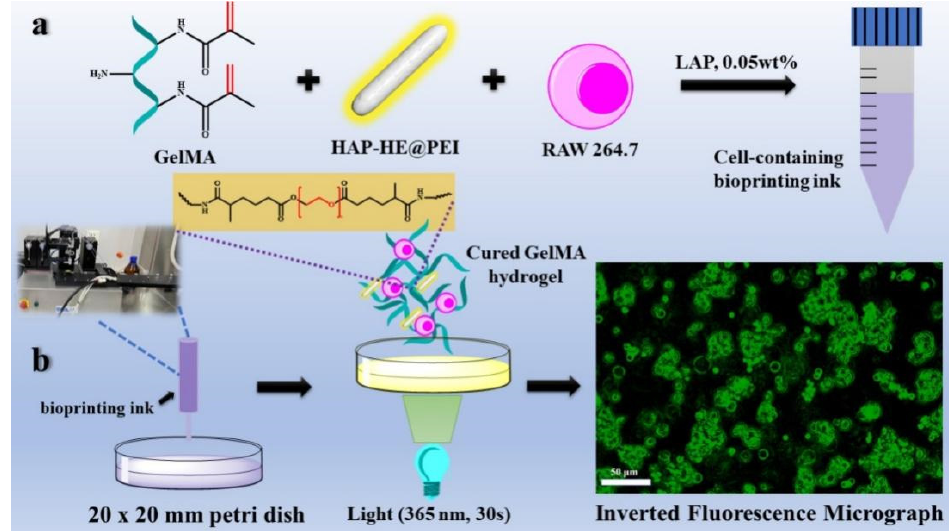
Figure 10. Bioprinting ink preparation and printing for 3D cell imaging process. ( a ) the preparation process of bio-ink (GelMA hydrogel containing 0.02 wt% HAP-HE@PEI). ( b ) 3D cell imaging process including 3D inkjet printing, photocuring, and collection of fluorescent images. (RAW 264.7 cells were grown in bio-ink for 12 h. HAP-HE@PEI: Ex = 440 nm, Em = 520 nm. Scale bar is 50 μ m).